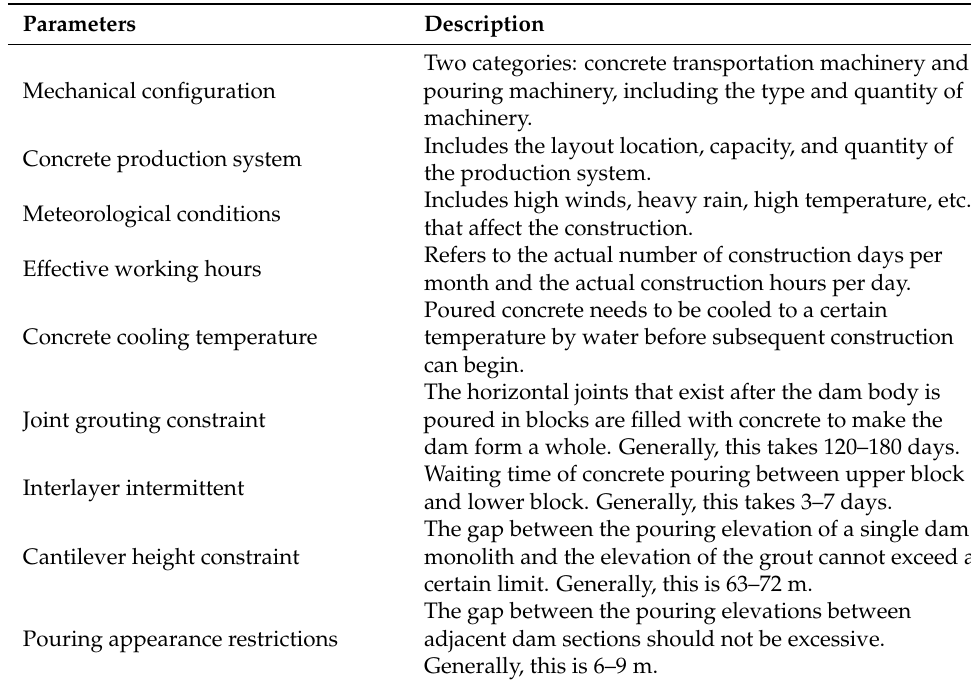
Table 2. Some construction conditions and simulation